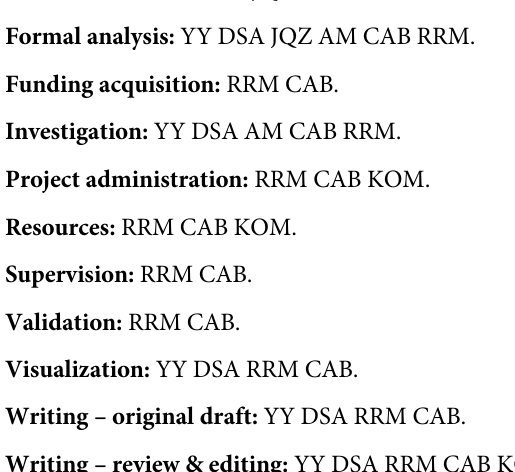
S6 Fig. Increased frequency of mature NK cells in healthy older subjects. (A) Frequency of total NK cells in young (n = 20) and old (n = 14) healthy subjects. (B-D) The NK dataset from young (n = 20) and old (n = 14) healthy subjects was analyzed by automated hierarchical clus- tering. (B) Stratifying clusters (yellow circles) including distinguishing clusters between the two groups (blue circles) and abundance of cells within the identified distinguishing clusters. (C) Expression of CD56, CD16, NKG2A and CD57 of stratifying clusters. (D) The phenotypic plots represent the clusters with different abundance between the younger and older subjects. All the phenotypic plots are representative of at least three independent runs. S1 Table. Antibodies used for flow cytometry and mass cytometry. S2 Table. Sequences for all the primers used for